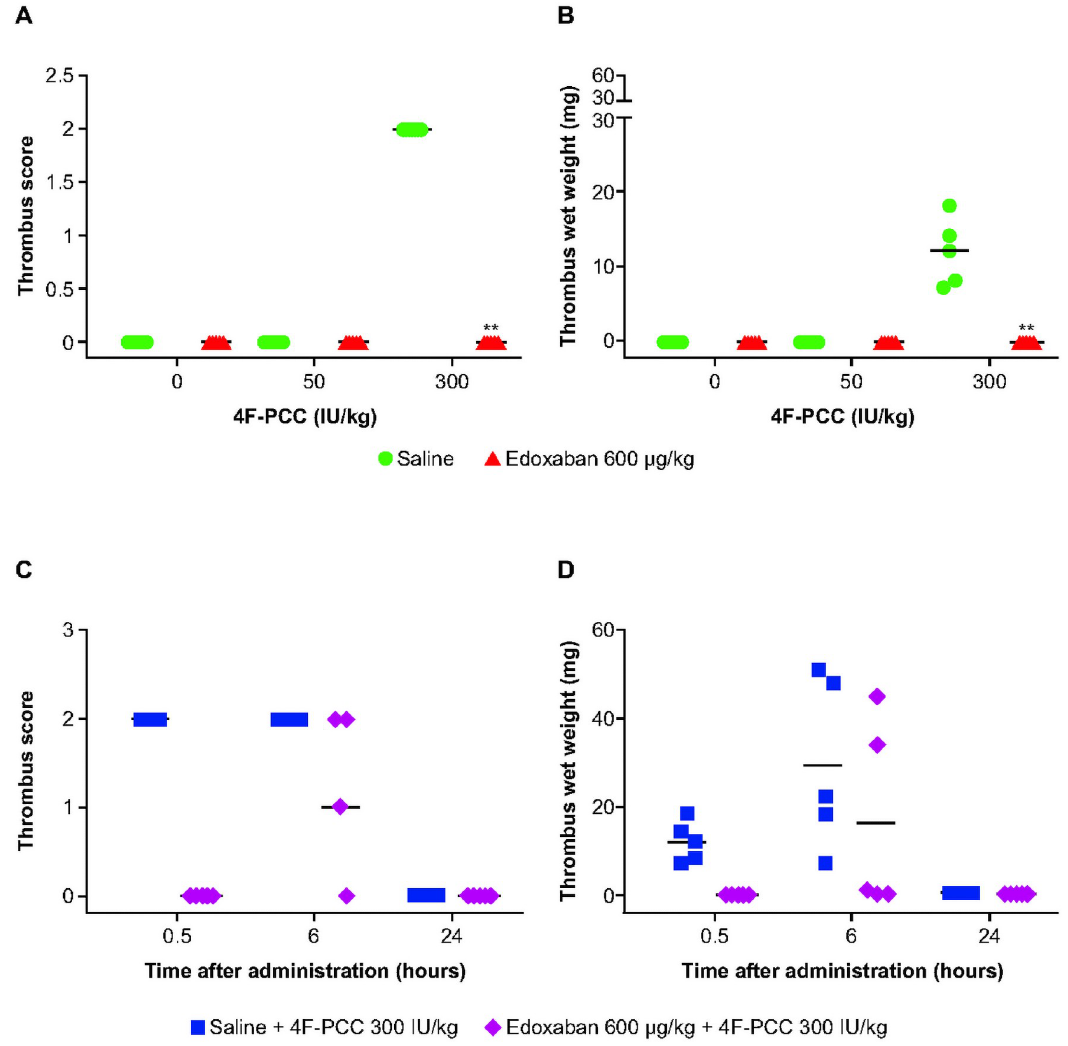
Fig 4. Data for venous stasis-induced thrombosis following end of PCC infusion. (A) Thrombus score and (B) thrombus wet weight at 30 minutes following administration of edoxaban (600 μ g/kg) or saline followed by 4F-PCC and venous stasis in rabbits; (C) thrombus score and (D) thrombus wet weight over time following administration of edoxaban 600 μ g/kg or saline followed by 4F-PCC (300 IU/kg) and venous stasis in rabbits. Figure shows median (range). �� P < 0.01.